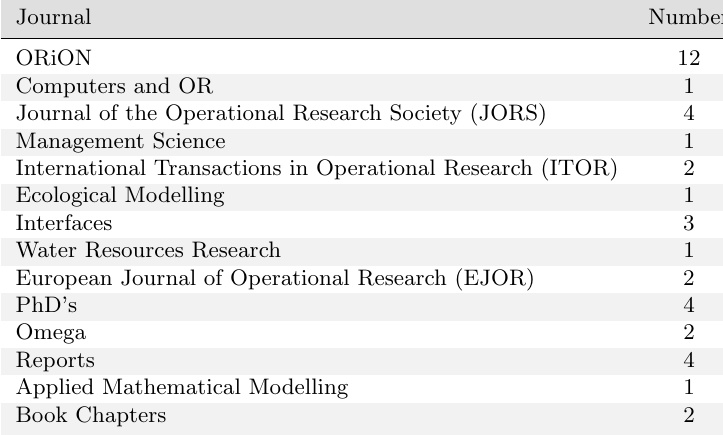
Table 3: Journals within which winning papers were published.